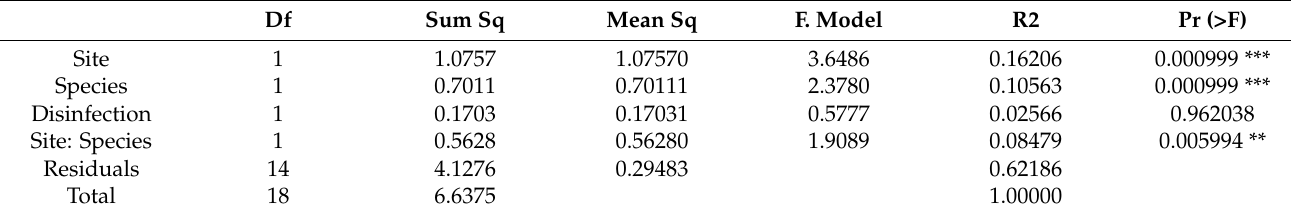
Table 3. PERMANOVA analysis (permutation = 1000) across egg samples based on three factors: aquaculture site (Site 1, Site 2, and Site 3), species (European seabass vs. gilthead seabream eggs), and disinfection (egg before vs. after